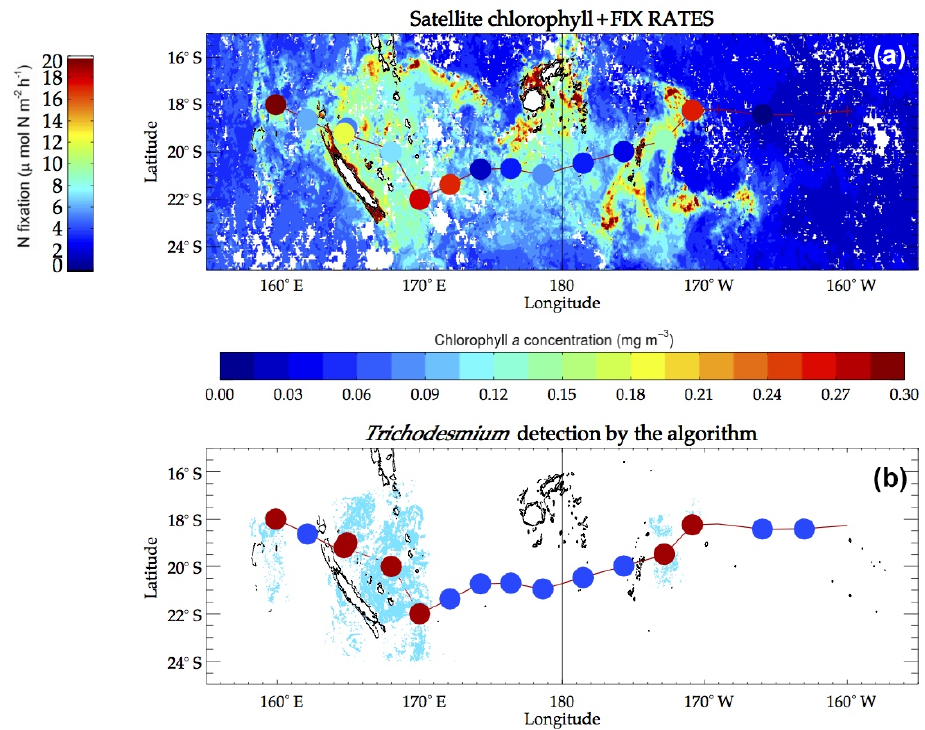
Figure 7. (a) Background is the monthly composite of satellite chlorophyll for March 2015, with the corresponding chlorophyll a concentra- tions given by the color bar underneath the map. Superimposed colored dots are in situ fixation rates measured on the OUTPACE track with values given by the left color bar. (b) In the background, cyan pixels are pixels detected as Trichodesmium by our algorithm. The colored dots superimposed show the absence (blue) or presence (red) of detected pixels within a radius of 50km around OUTPACE